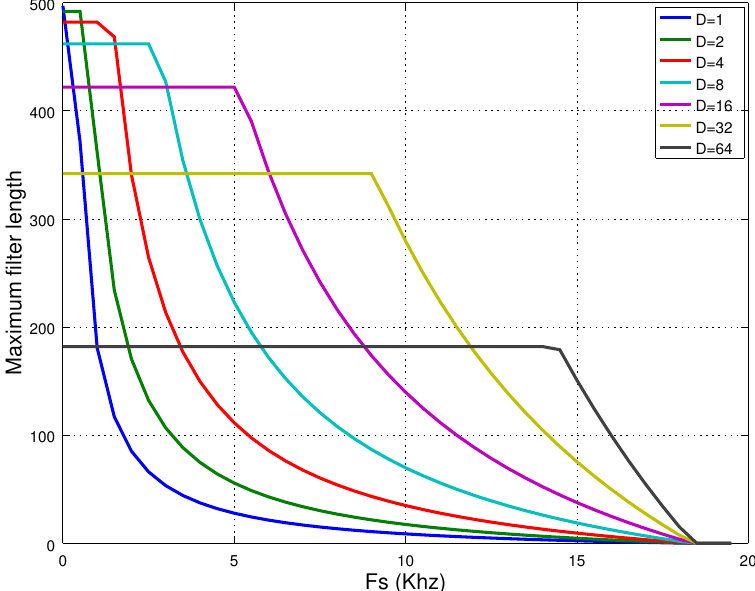
Figure 9. Theoretical maximum filter length as a function of the sampling rate ( F s ) and decimation factor D. Each curve has been obtained by taking into account the room in the memory hosting the coefficients and the data, and the time available to compute the filter output as only one input channel is